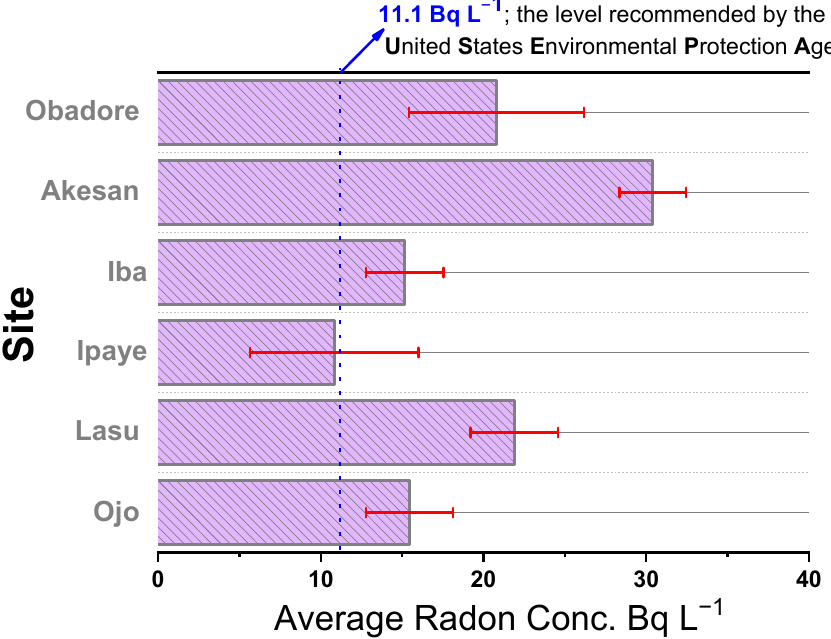
Figure 5. The average activity concentrations of radon, independent of the source (sea, well, borehole, and sachet water).